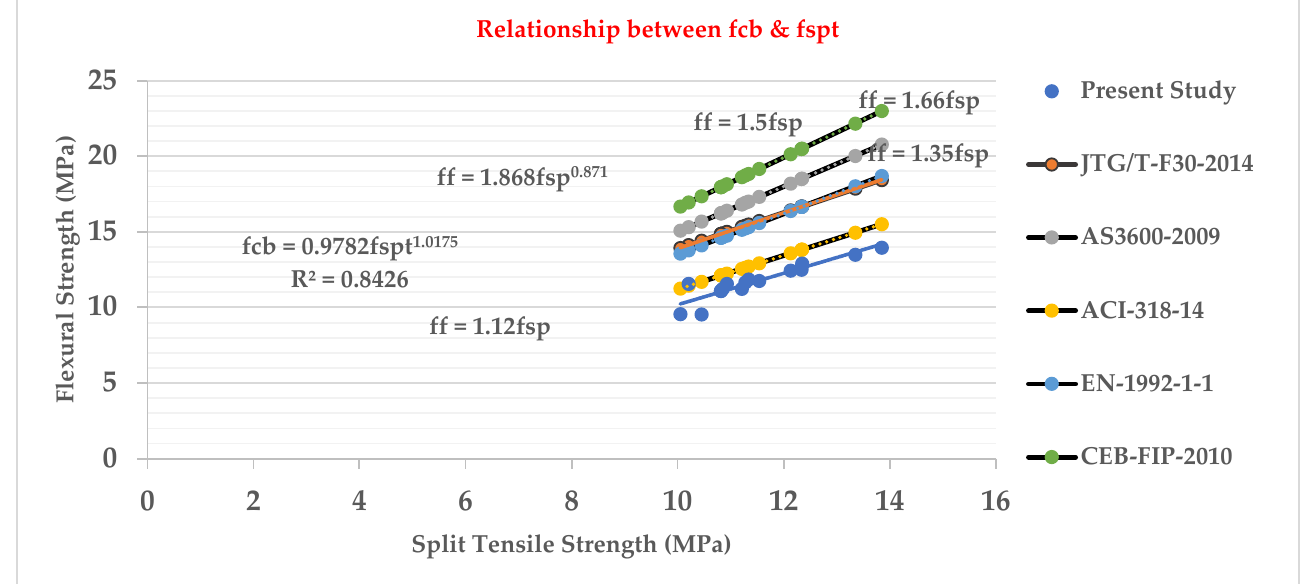
Figure 9. Relation between flexural strength and split tensile strength.